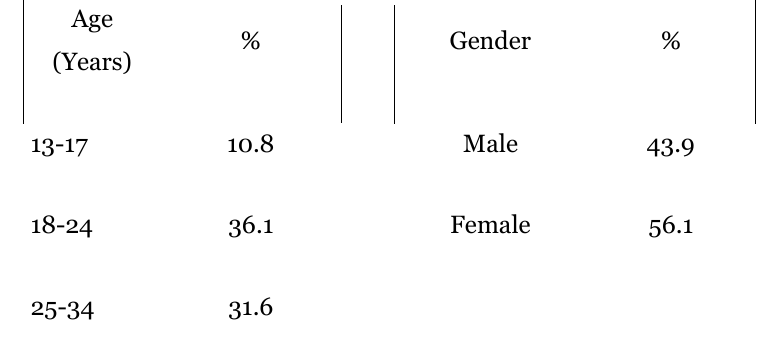
Age and Gender Distribution of Facebook users in the Kingdom of Tonga as of June